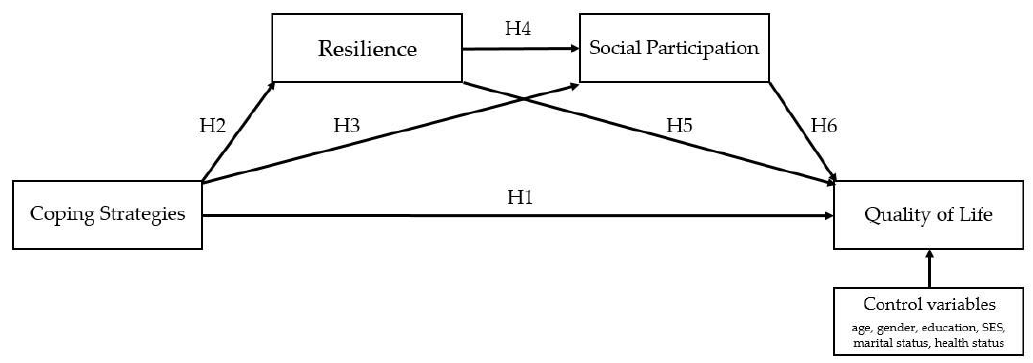
Figure 1. The theoretical framework of the study.